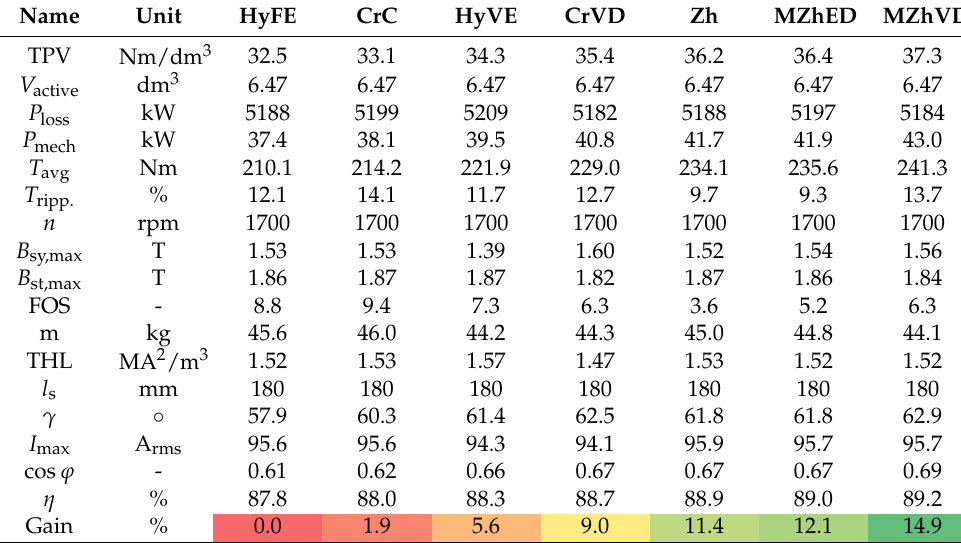
Figure 12. Validated Pareto front within constraints g 2 and g 6 . Dotted colored lines represent estimated Pareto fronts. N pareto is the number of designs placed on each front. Table 5. Final result comparison